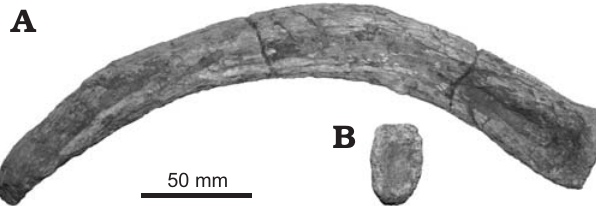
Fig. 6. Dorsal rib of the plesiosaur Rhomaleosauridae indet., SGM 1445- 100, from the Lower Callovian Hlebnovka Formation of “Konnyi barak” ravine, Russia, in ?anterior ( A ) and proximal ( B )